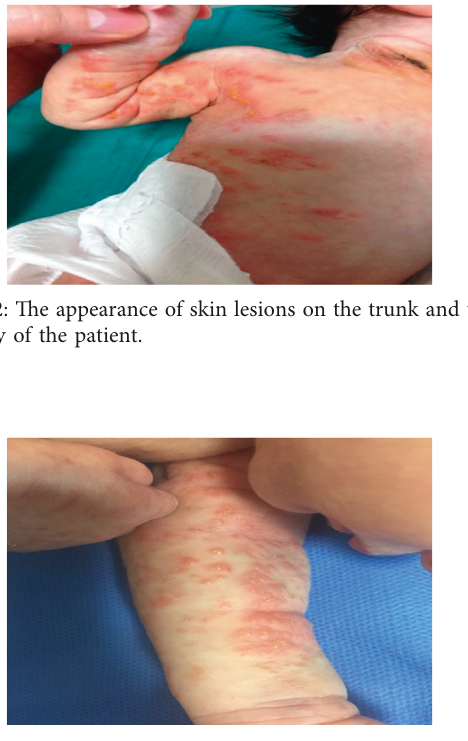
Figure 3: The appearance of skin lesions on the arm of the patient.